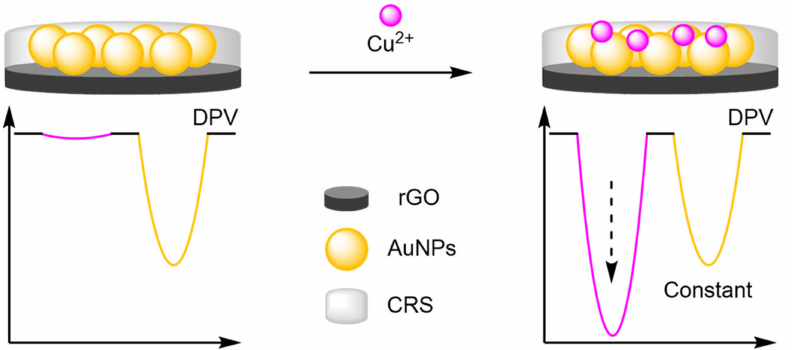
Figure 29. Schematic representation of a resin-supported nanoparticle-based modified electrode for the detection of Cu 2+